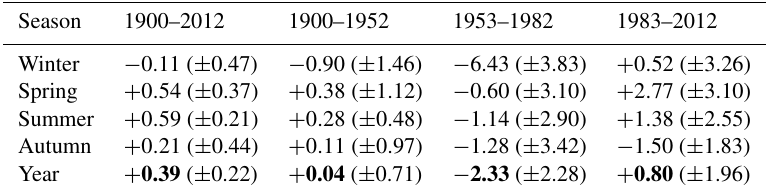
Figure 3. Full time series of de-seasonalized SSR percent changes (using the 1900–2012 monthly averages). (a) Different colors represent seasonal analysis; (b) the black bold line represents the annual series and light blue line the mean monthly values. Table 3. Annual and seasonal SSR trends in percent per decade over the period 1900–2012 and different sub-periods. Percentages in paren- theses show the limits of the 95% confidence bounds and in bold the yearly